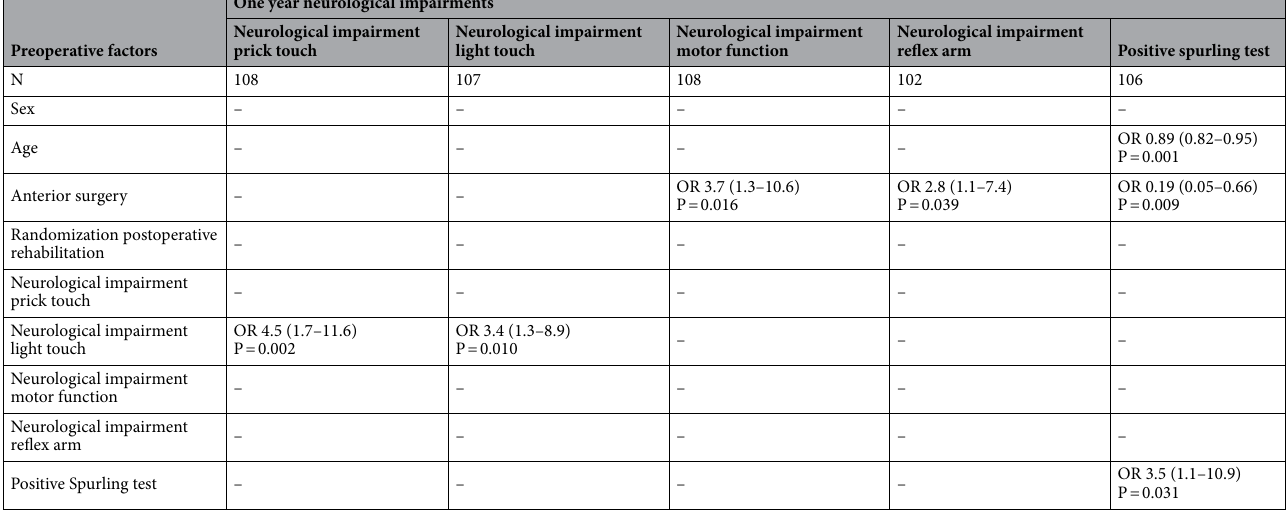
Table 4. Preoperative predictors of one-year persistent neurological impairments. Results from multiple forward logistic regression analysis are presented with odds ratio (OR), 95% confidence interval, and p